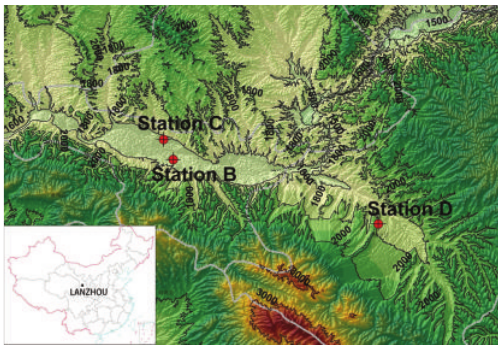
Figure 1: Location of measurement stations in the contour map of Lanzhou (the inset map shows the location of Lanzhou in